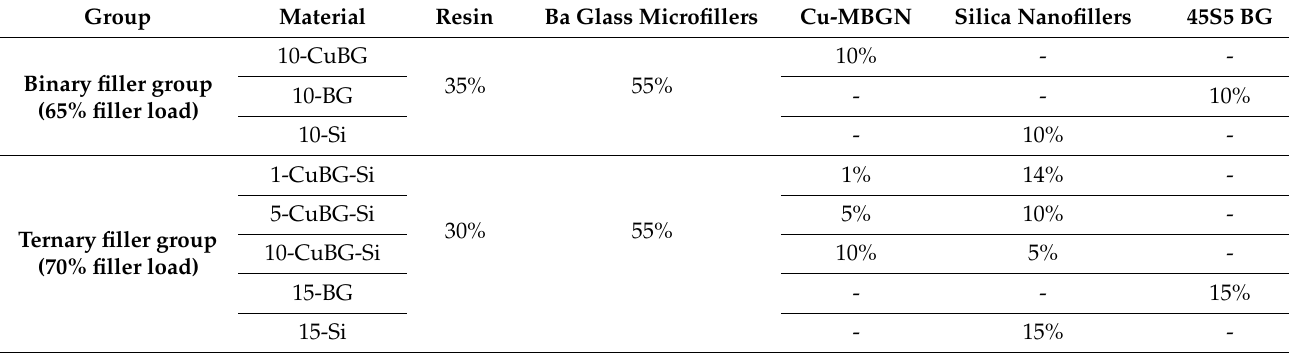
Table 1. Composition of experimental resin composites. Resin is 60/40 BisGMA/TEGDMA. All the amounts are expressed in wt%.